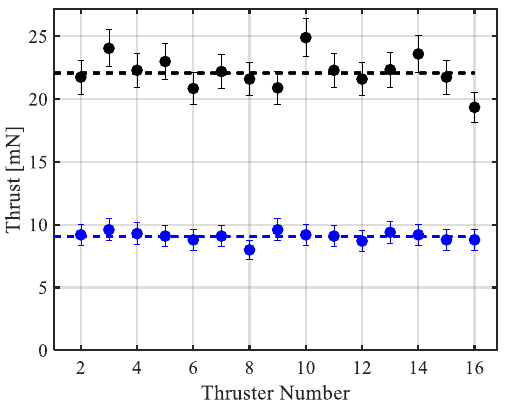
Figure 12. Measured thrust for the 16 thrusters at an inlet pressure of 60 psig (black) and 30 psig (blue) under atmospheric environment and using nitrogen as a propellant.